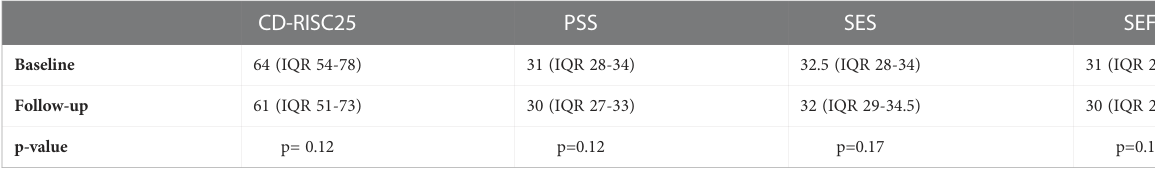
TABLE 2 Baseline vs follow-up values of the questionnaires assessed in the study.